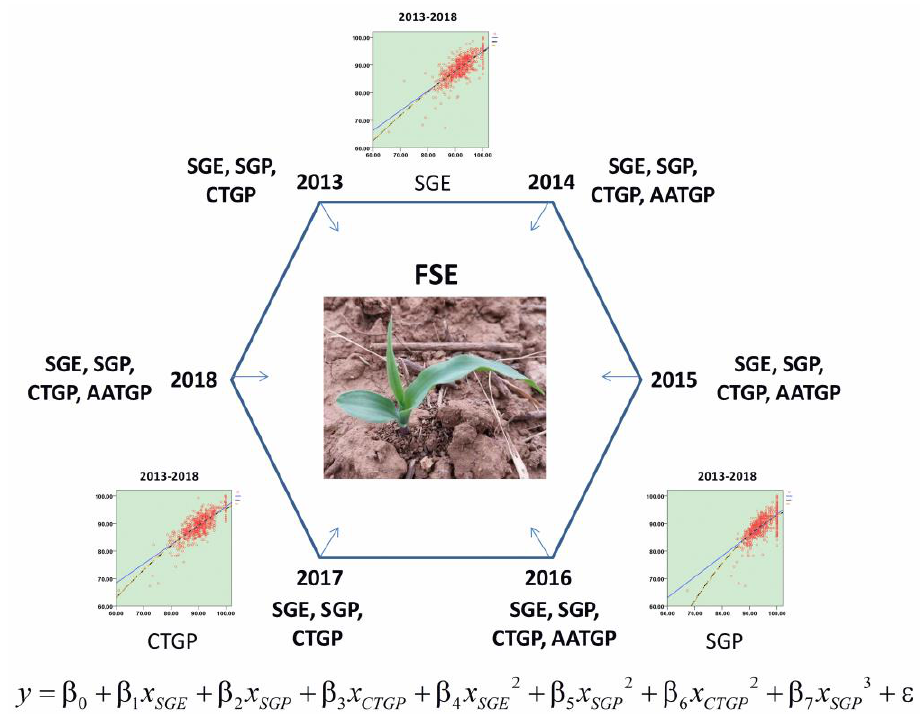
Figure 4. Model establishment and solution. Note: SGE—standard germination energy;